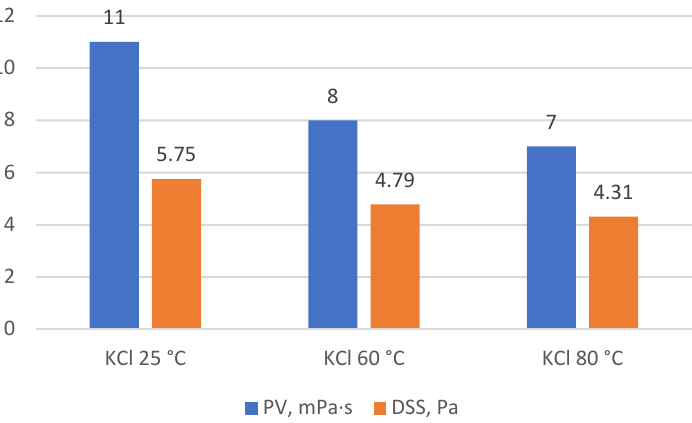
Figure 4. Plastic viscosity (PV) and dynamic shear stress (DSS) of KCl-based drilling mud at different temperatures.